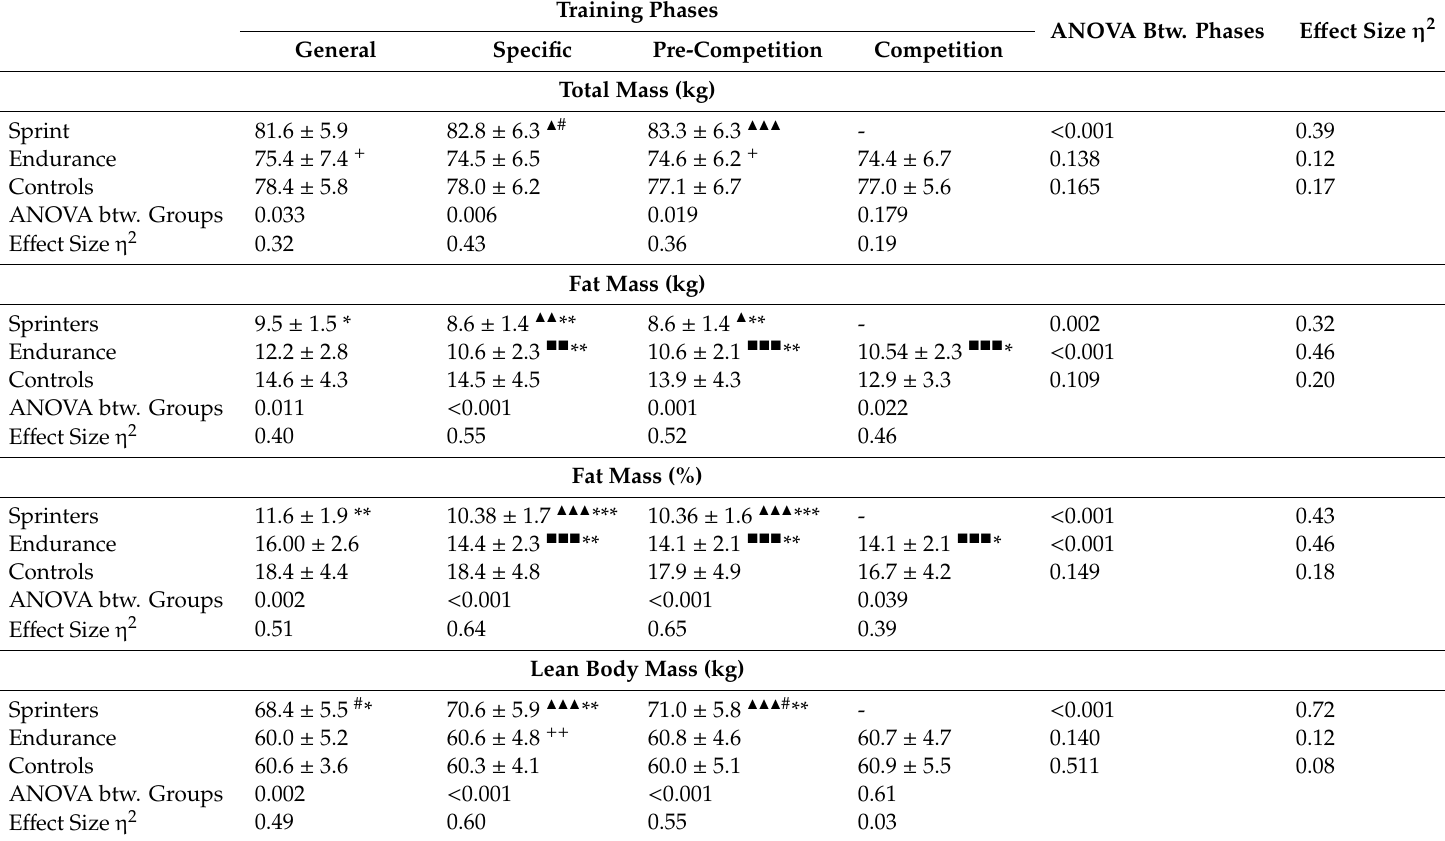
Table A1. Changes in body composition between consecutive phases of the annual training cycle in athletic groups and